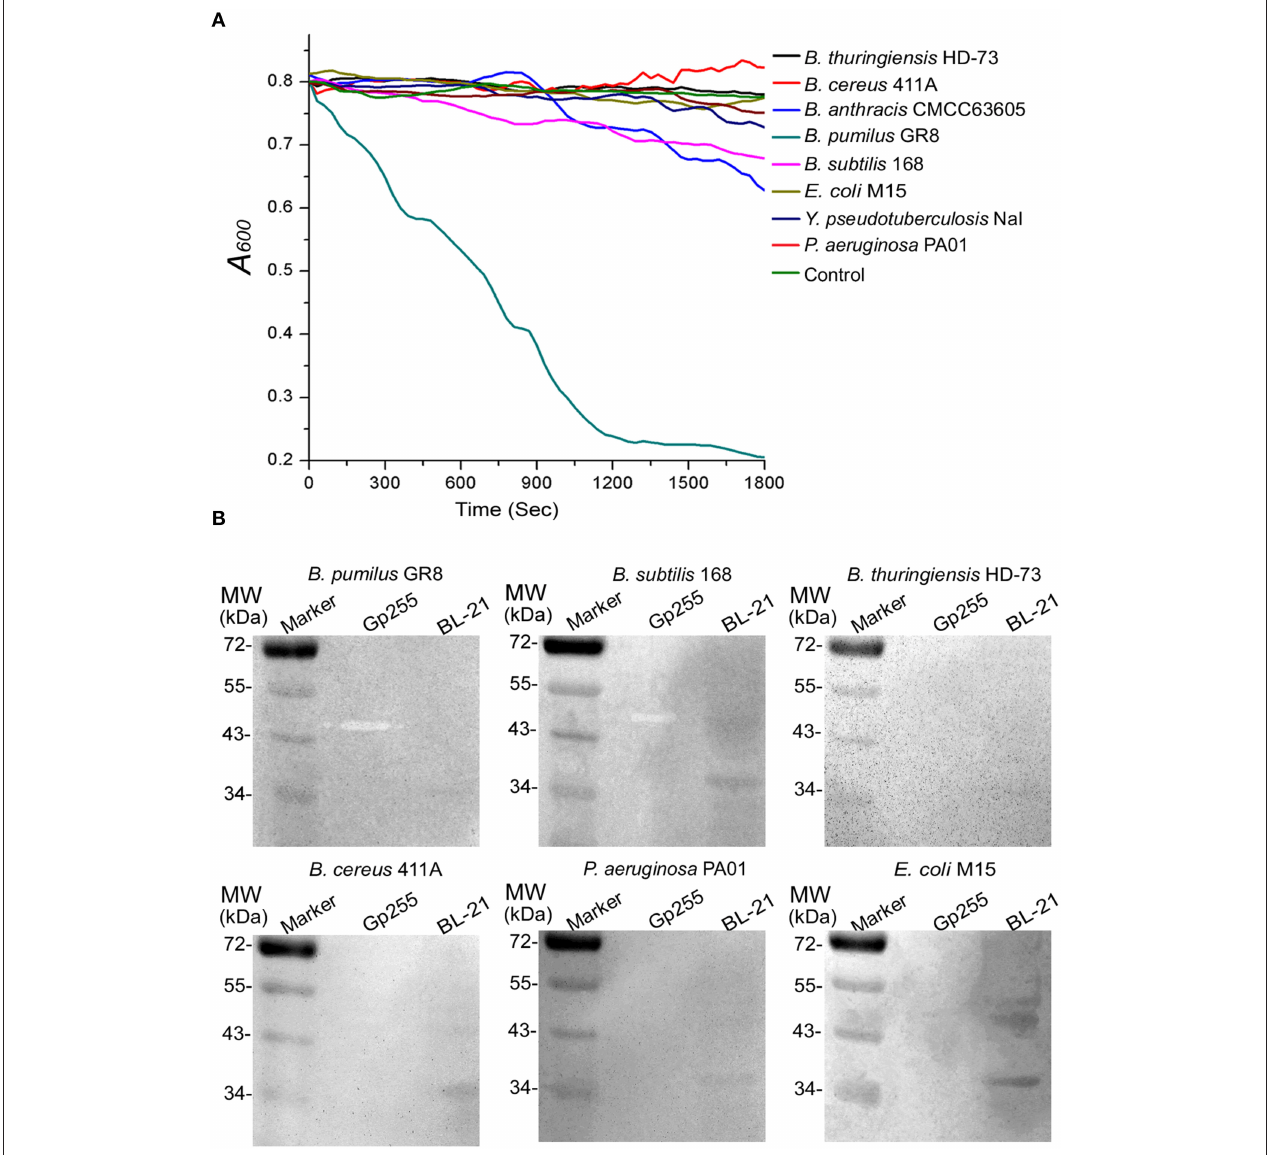
FIGURE 4 | Lytic specificity of Gp255. (A) Lytic activity of Gp255 against eight tested strains. The suspension of exponential-growth GR8 without adding Gp255 was used as control. For the Gram-negative strain, EDTA was added into the reaction buffer at a concentration of 1mM. (B) In-gel lytic activity assay of Gp255. The crude cell extracts of six strains were